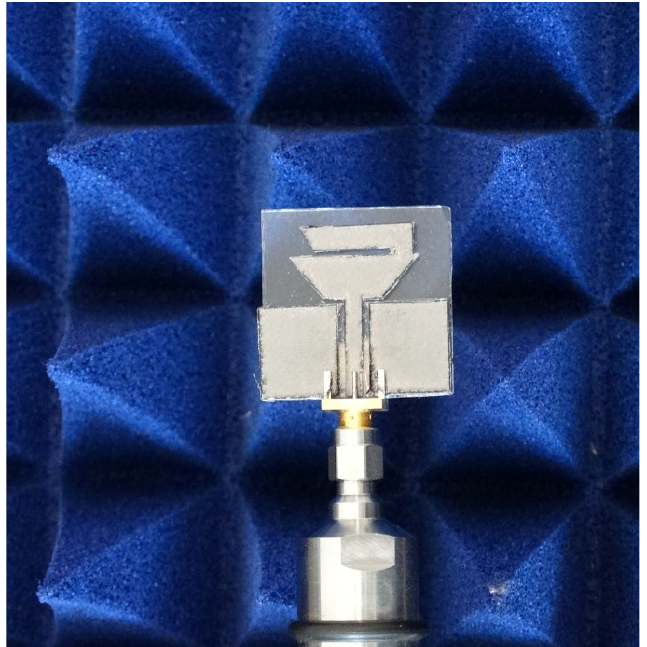
Figure 6. Fabricated dual ‐ band graphene antenna.